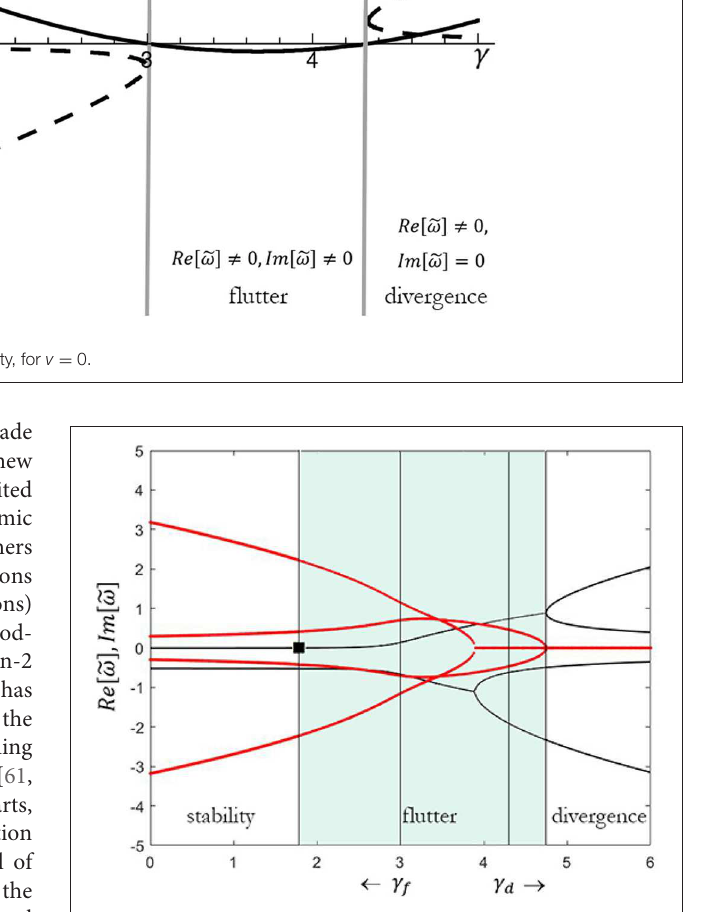
FIGURE 11 | Real (black line) and imaginary (red line) part of the eigenvalues vs. dimensionless follower load γ , for ν